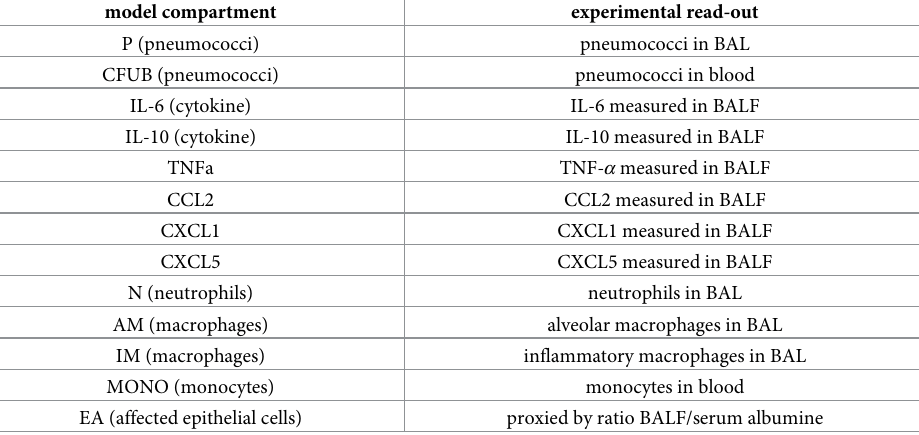
Table 1. Data and corresponding model